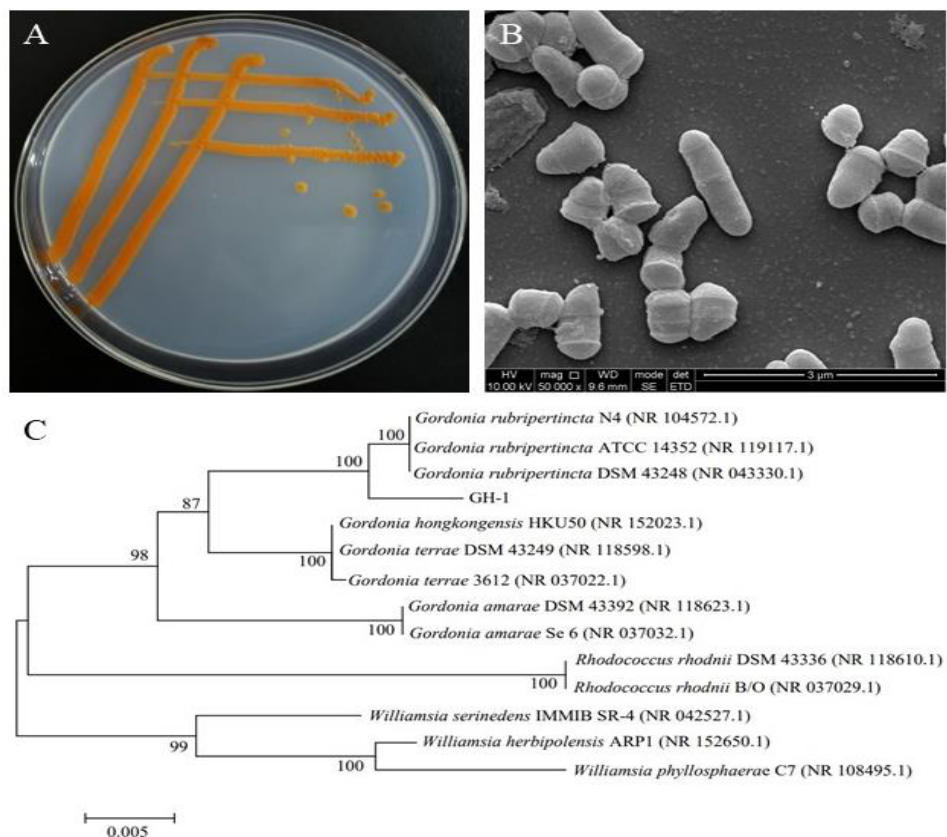
Figure 1. Colony ( A ), cell morphological ( B ) characteristics and phylogenetic tree ( C ) of strain GH-1.